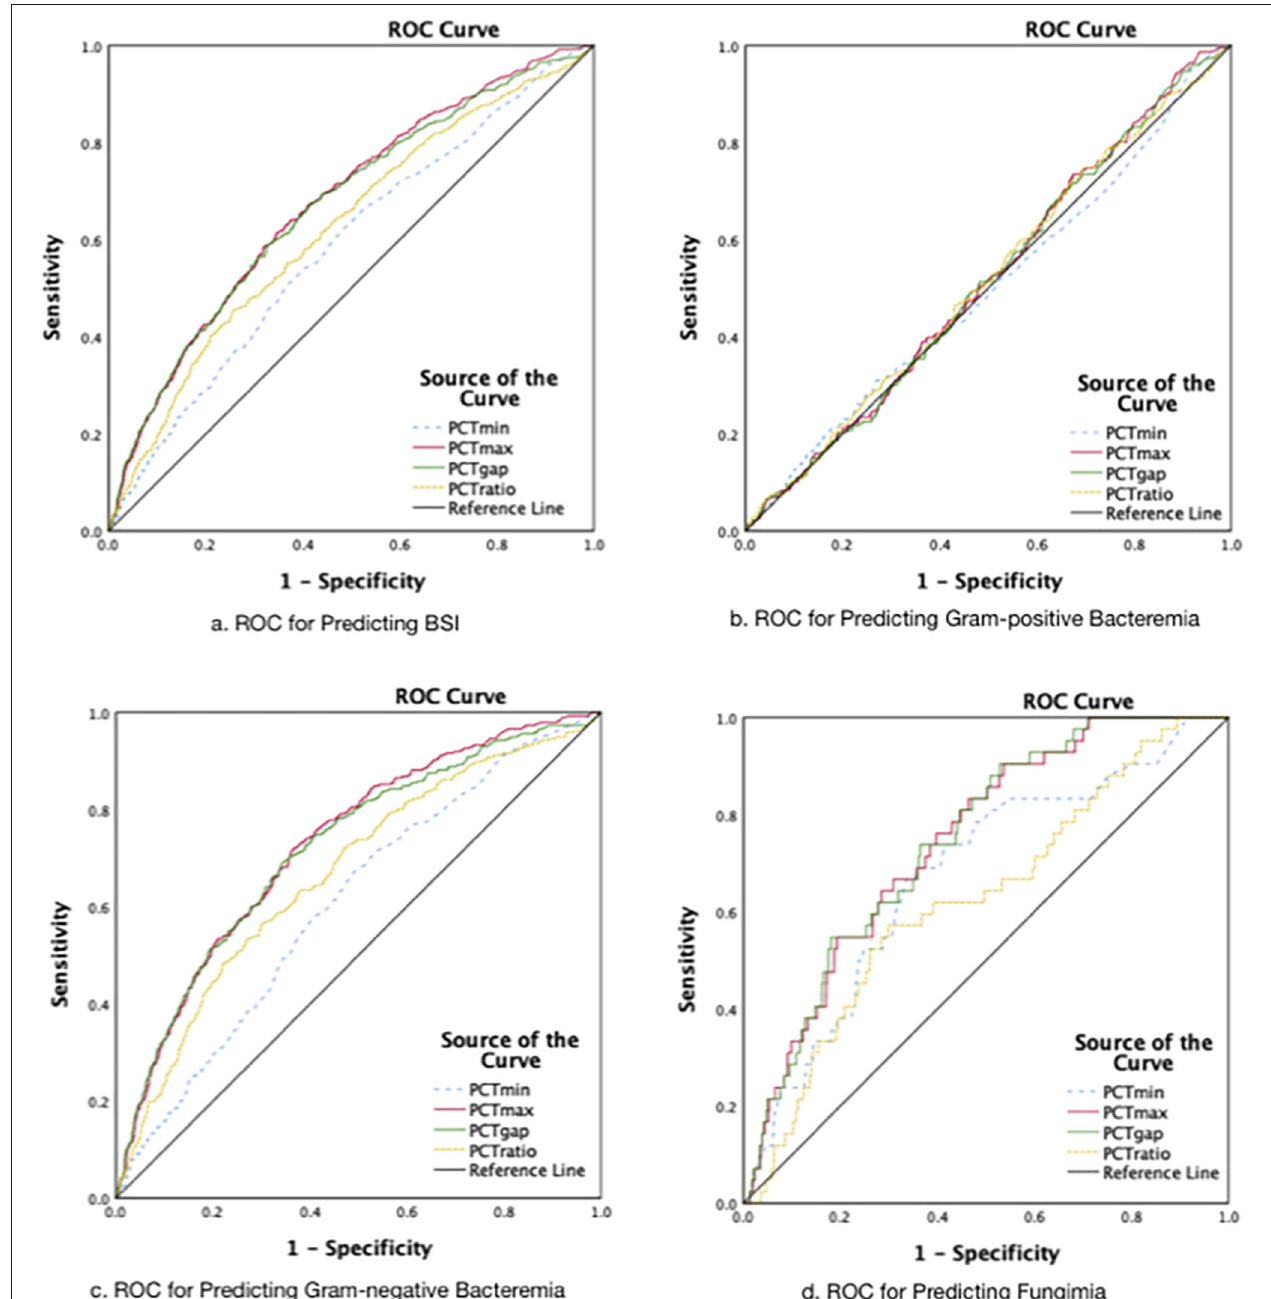
FIGURE 3 | The receiver operating characteristic curves. (A) The AUROCs: for PCTmin 0.59.for PCTmax 0.68, for PCTgap 0.67, for PCTratio 0.62 (Group 2 + 3 + 4 vs. Group l; P < 0.001). (B) The AUROCs: for PCTmin 0.50 ( P = 0.96), for PCTmax 0.52 ( P = 0.41), for PCTgap 0.51( P = 0.50), for PCTratio 0.52 ( P = 0.41). (C) The AUROCs: for PCTmin 0.61, for PCTmax 0.73, for PCTgap 0.72, for PCTratio 0.67 ( P < 0.001). (D) The AUROCs: for PCTmin 0.68, for PCTmax 0.74, for PCTgap 0.75 for PCTratio 0.63 ( P < 0.001).